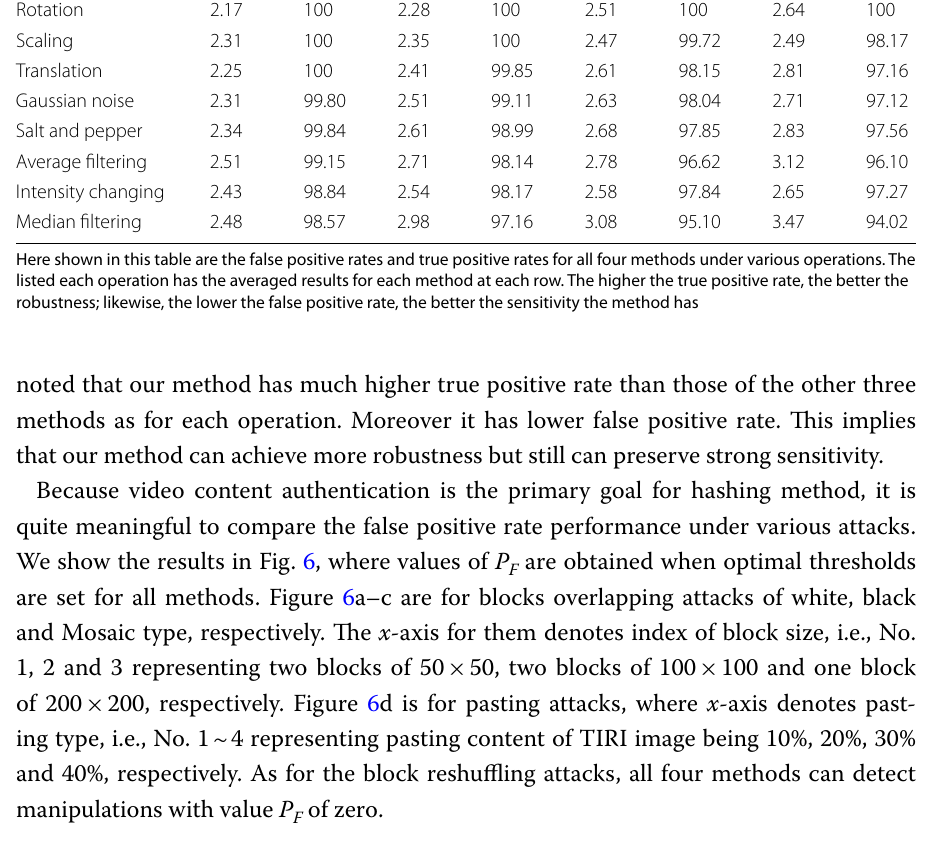
Table 1 Robustness and sensitivity performances of the perceptual content preserving operations Methods Our